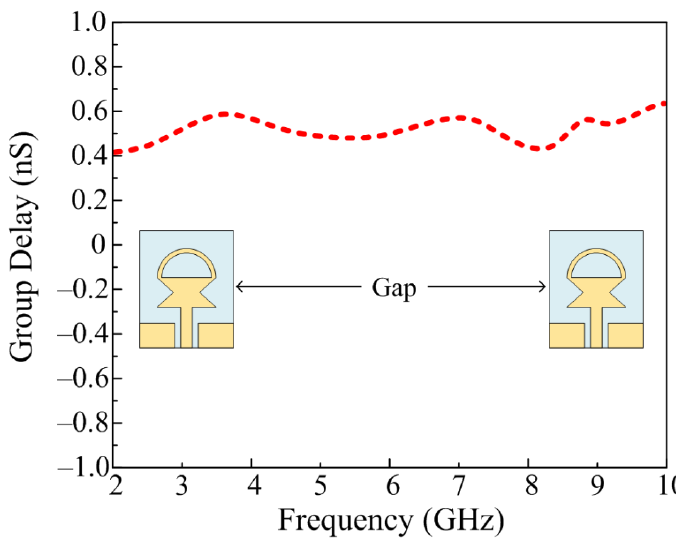
Figure 13. Gain of the proposed work for conformal and non-conformal scenarios.